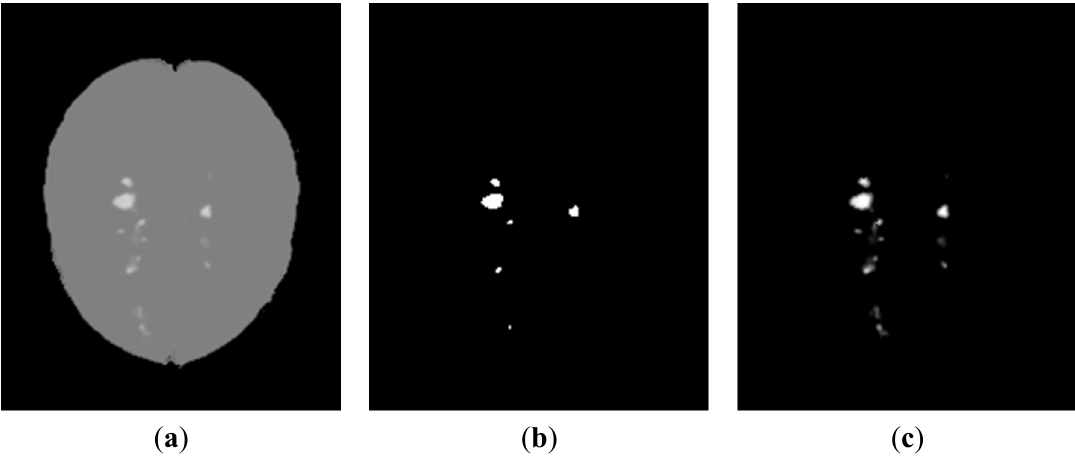
Figure 7. ( a ) Figure 3a after the initial pseudo-grayscale conversion by Equation